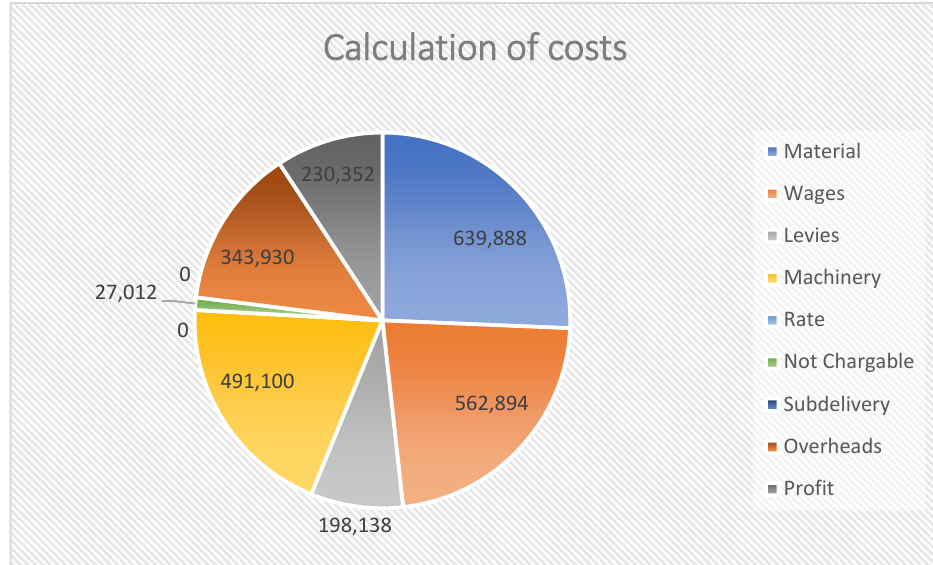
Figure 7. Displaying the calculation structure of the cost and profit on the contract (illustrative example) [26].